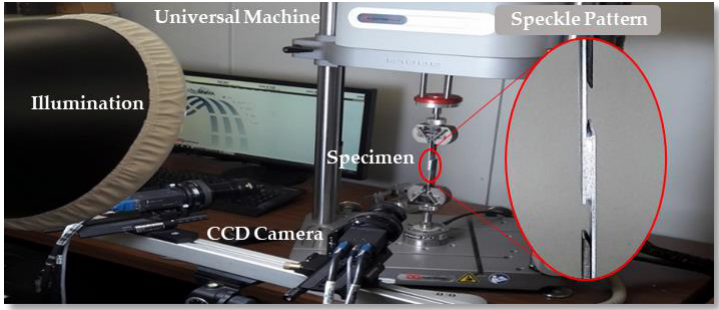
Figure 4. Experimental set-up of 3D digital image